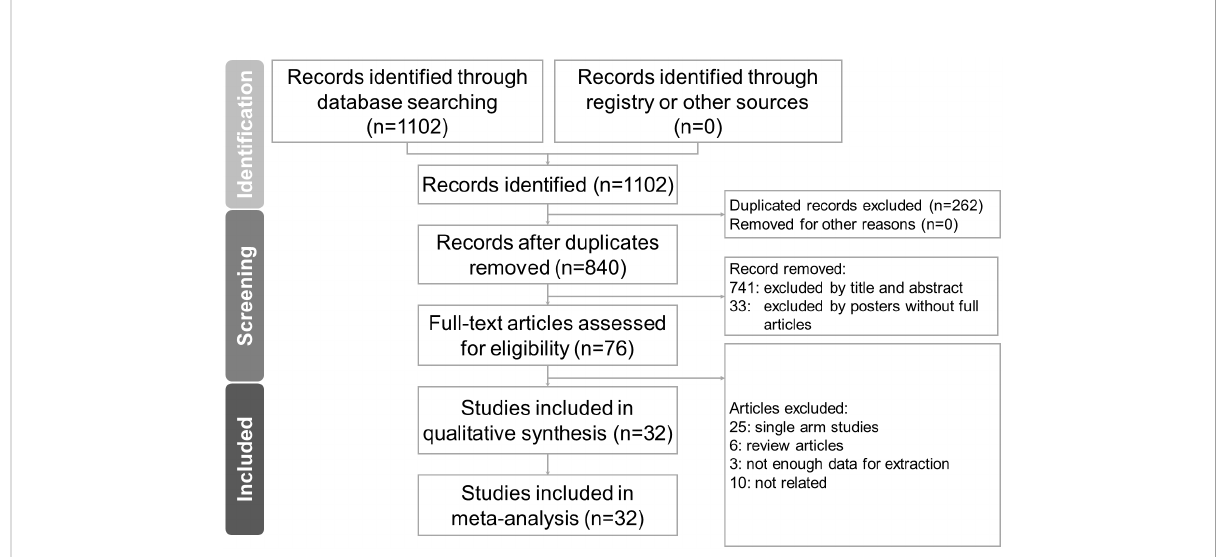
FIGURE 1 PRISMA (Preferred Reporting Items for Systematic Reviews and Meta-Analysis) fl owchart of article selection